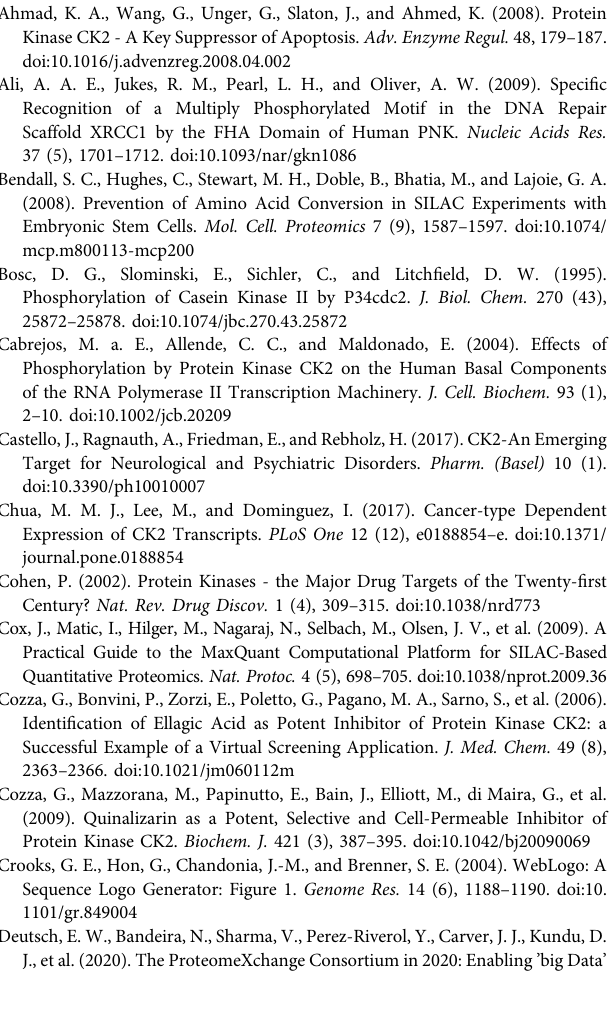
Supplementary Figure S4 | Characterization of Flp-In T-REx U2OS parental, CSNK2A1-HAwildtype(WT) andtriplemutant(TM,V66A/H160D/I174A) celllines in immuno fl uorescence (IF) experiments. Exogenous CSNK2A1-HA WT or CSNK2A1-HA TM expression in the cells were induced with 1 μ g/mL Tetracycline. Cells were asynchronous or cell cycle arrested with double Thymidine block (Roberts et al., 2006) before IF labelling with the indicated anti-HA/Alexa 488 (FITC, Thermo Fisher Scienti fi c) antibody and the nucleus was stained with Hoescht 33342 (DAPI, Thermo Fisher Scienti fi c). Scalebar indicates 50 μ m on images. Figures are presenting results from two independent experiments. Supplementary Figure S5 | Pro fi le plots of distinct phosphopeptides which were signi fi cantly inhibited and rescued, categorized based on corresponding protein. The horizontal dashed line represents 1.5-fold signi fi cant inhibition ( − 0.585). Supplementary Figure S6 | Comparison of rescued phosphopeptides with corresponding differential protein expression. Vertical and horizontal lines (-/+ 0.585) are indicative of signi fi cant down- and upregulation of phosphosites and proteins.